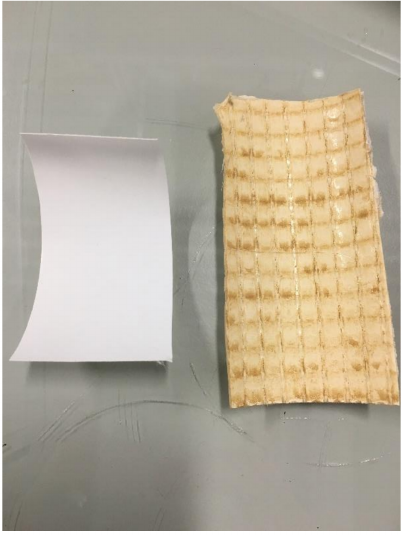
Figure 7. New DK membrane ( left ) vs. post trial DK membrane ( right